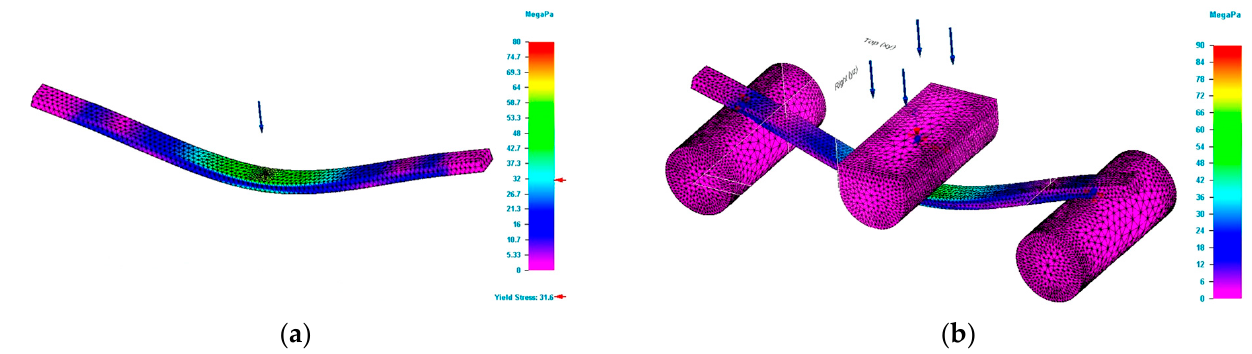
Figure 4. Result of simulation process for G_R5 specimen (Von Mises stress). ( a ) Von Mises stress for simple modelling. ( b ) Von Mises stress for complex modelling. Table 2. Comparison between results of the tests and simulation, for 3D printed specimens, bend- ing